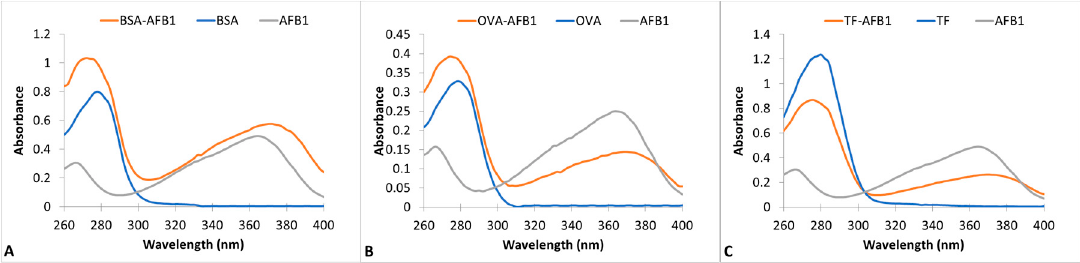
Figure 1. UV-VIS absorption spectra of AFB1-Protein conjugates between 260 nm–400 nm wavelengths. ( A ) BSA-AFB1, BSA, and AFB1; ( B ) OVA- AFB1, OVA, and AFB1; ( C ) TF-AFB1, TF, and AFB1.